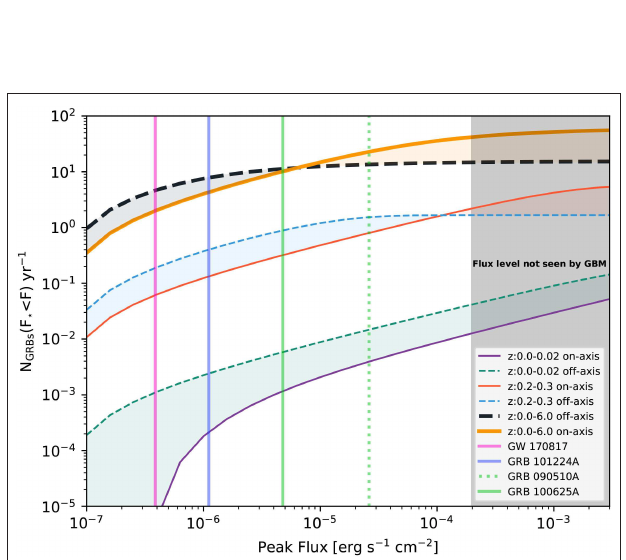
FIGURE 5 | The cumulative short-GRB rate distribution is shown as a function of flux integrated over F ∗ to F , calculated by assuming a jet structure and luminosity function and then convolving this with the binary neutron star merger rate for various redshift integration ranges. The GRBs with redshift in our sample are plotted for comparison. The shaded region on the right indicates the flux values for which GBM has not observed a